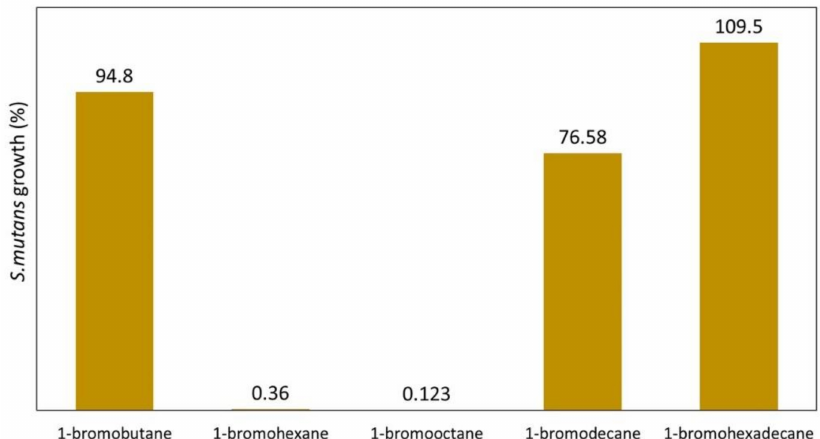
Figure 7. S. mutans growth (%) on the surface of a commercial dental composite enriched with 1 wt.% QA-PEI nanoparticles, which were telomerized using alkyl bromides of various lengths. Data from [85].